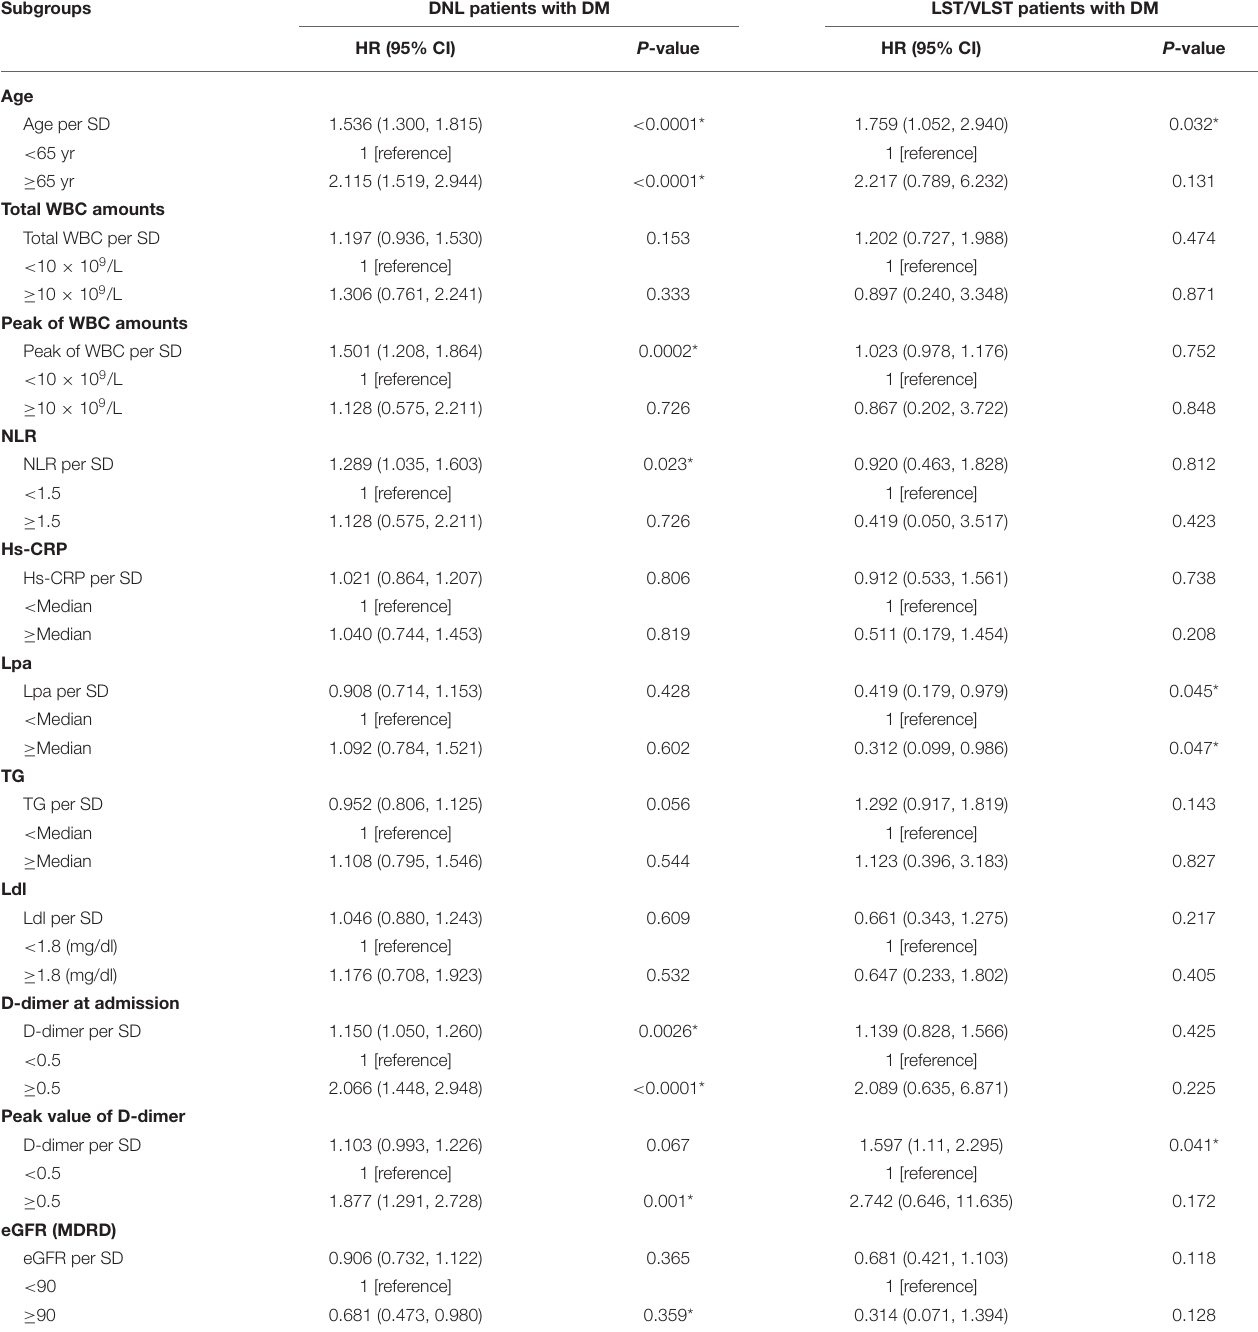
TABLE 2 | Association between MACE and different subgroups of variables among patients with DM.